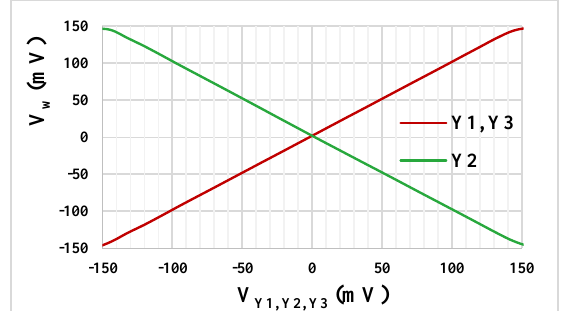
Figure 7. The DC transfer characteristics of the DDCC.